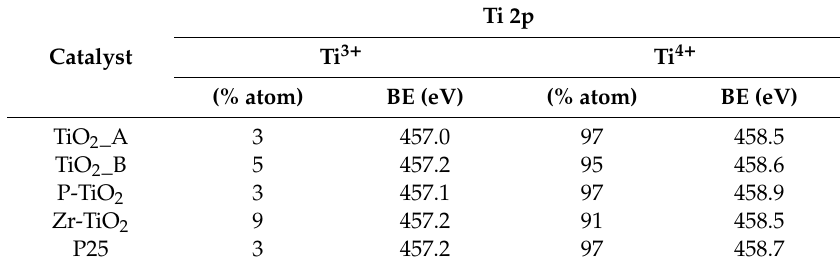
Figure 7. X-ray photoelectron spectra of the samples in the Ti 2 p core level. Table 5. Relative abundances of Ti species (in atomic percentage) derived from deconvoluted Ti 2 p XP spectra.